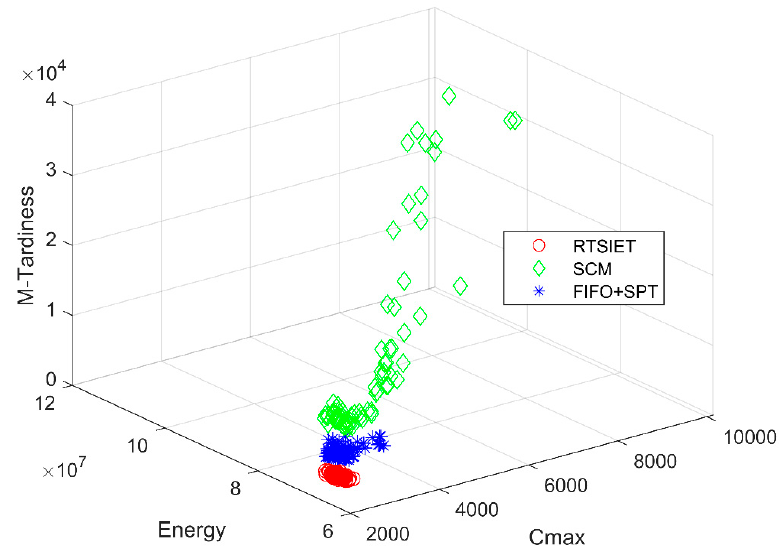
Figure 4. Pareto front of three algorithms in solving the proposed problem.